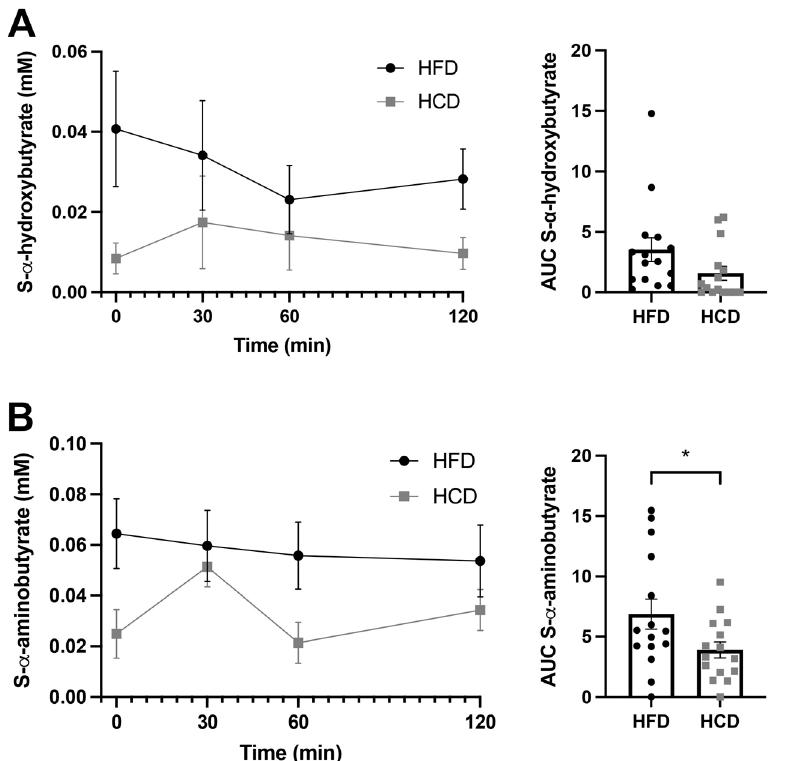
Figure 4. Serum levels of α -hydroxybutyrate ( A ) and α -aminobutyrate ( B ) in normal-weight, healthy subjects after two weeks of HFD (circles) vs. HCD (squares) in a cross-over design study, 0–120 min after a mixed meal test (MMT). The meal was ingested within the first 10 min starting at 0 min. The area under the curve (AUC), presented on the right in each panel, for each individual was calculated from the time profile. * p < 0.05, using the Wilcoxon test.